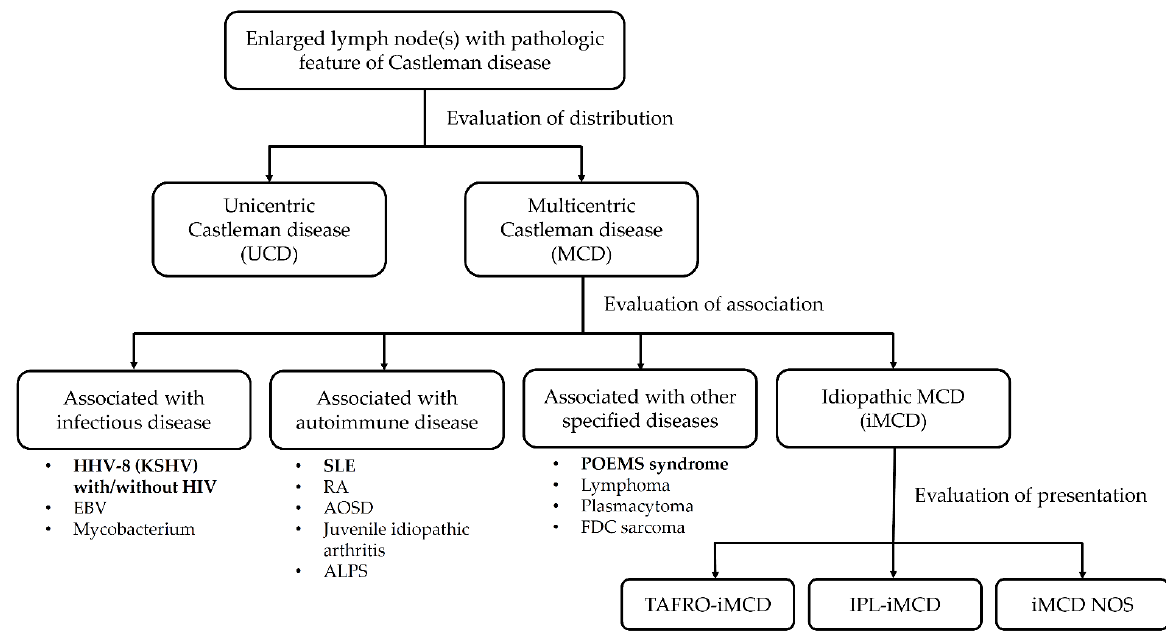
Figure 1. Diagnosis algorithm of Castleman disease. Abbreviation: ALPS, autoimmune lymphoproliferative syndrome; AOSD, adult-onset Still’s disease; EBV, Epstein-Barr virus; FDC sarcoma, follicular dendritic cell sarcoma; HHV-8, human herpesvirus 8; HIV, human immunodeficiency virus; IPL, idiopathic plasmacytic lymphadenopathy; KSHV, Kaposi’s sarcoma-associated herpesvirus; RA, rheumatoid arthritis; SLE, systemic lupus erythematosus.